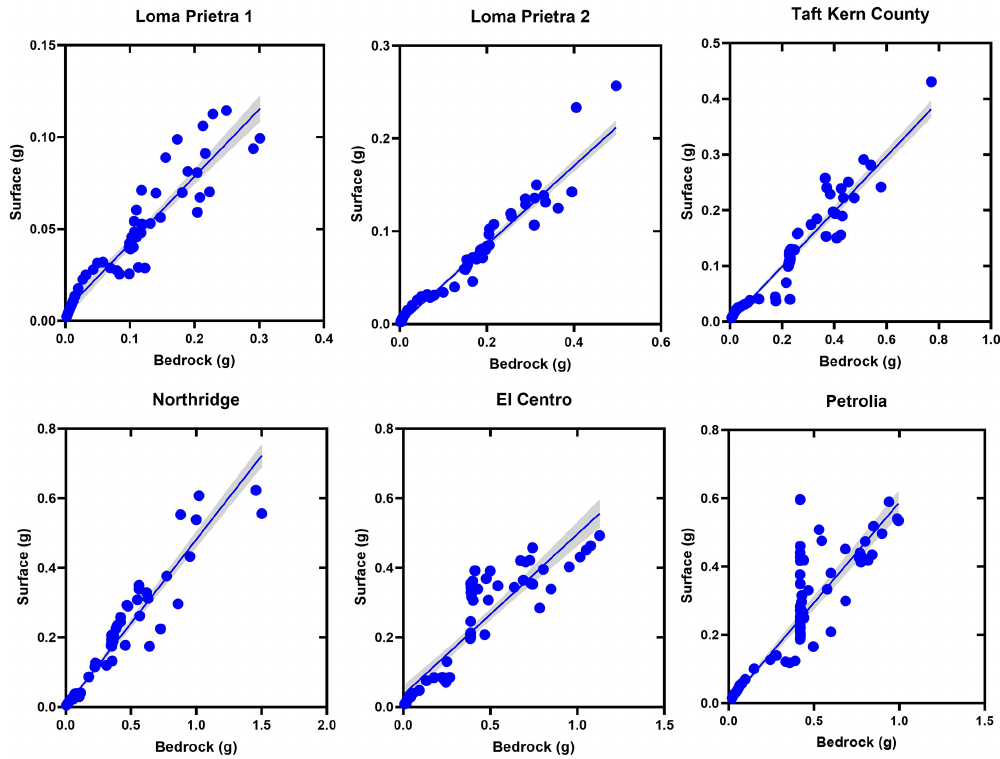
Figure 15. Linear regression model for bedrock and surface spectral accelerations for CST hostel (Zone II).